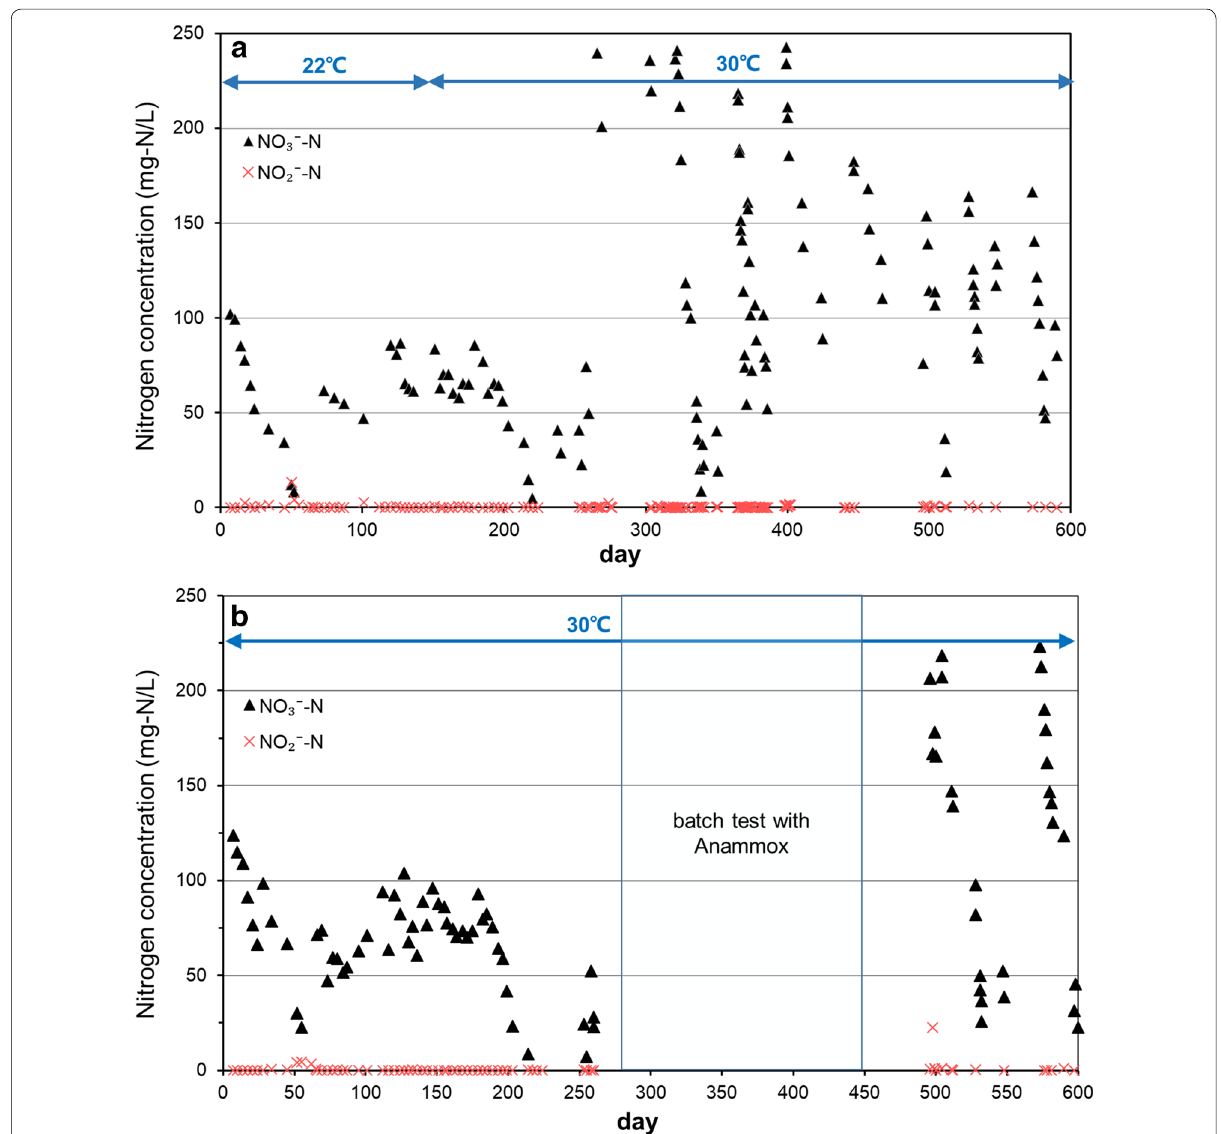
Fig. 1 Nitrate and nitrite concentrations in the reactor during the 600 days. a Nitrate and nitrite concentration changes in reactor A; b nitrate and nitrite concentration changes in reactor